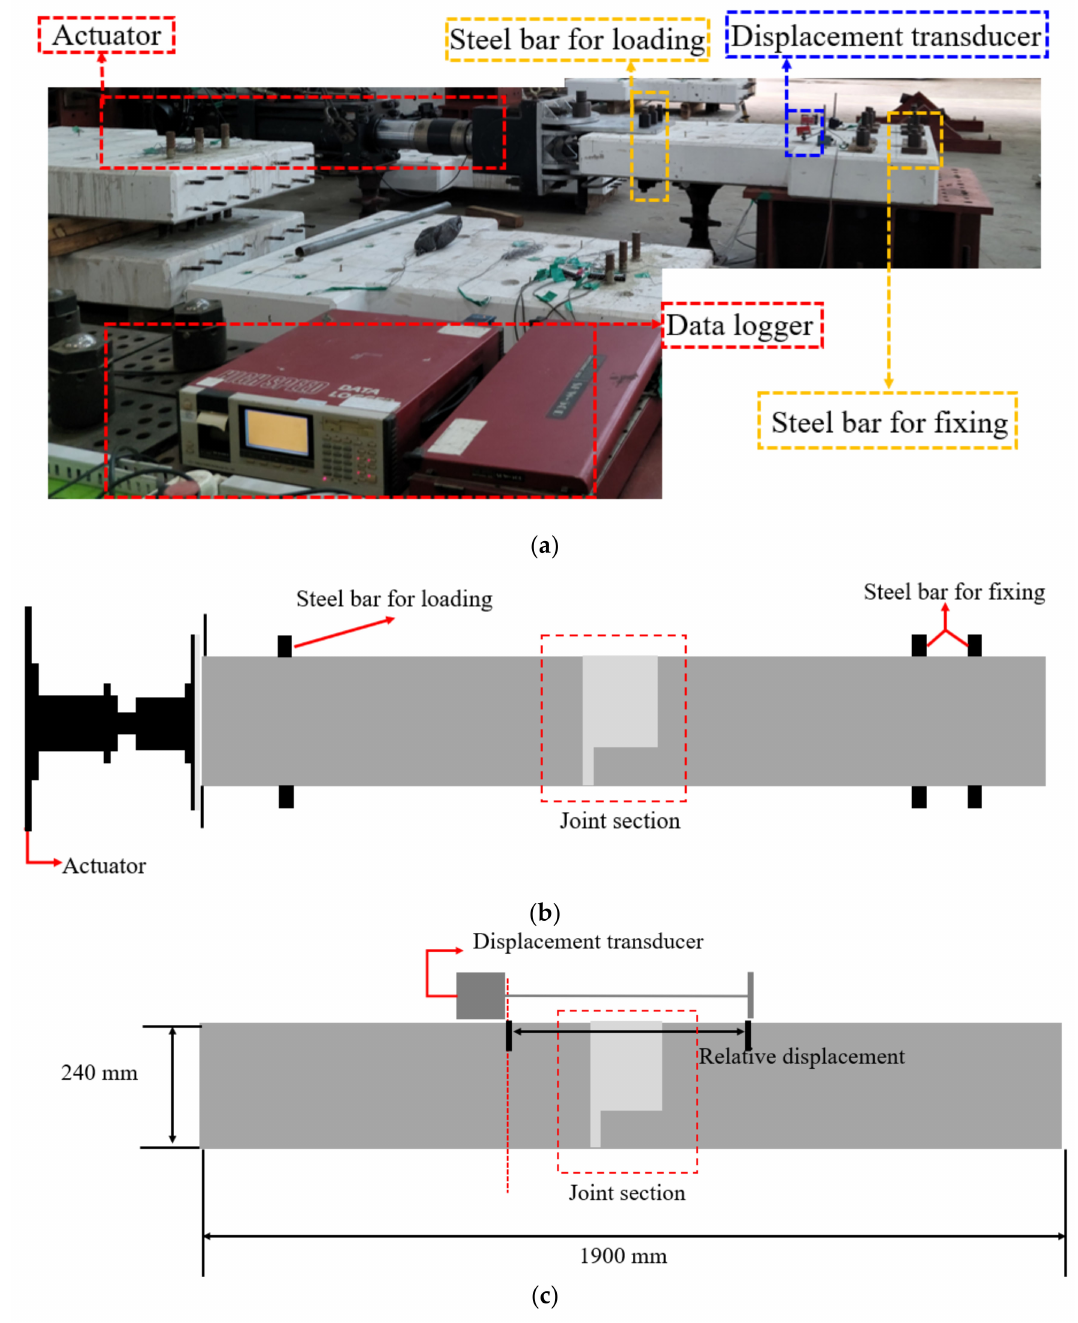
Figure 4. Test setup: ( a ) experimental view, ( b ) test setup for loading, and ( c ) measurement of relative